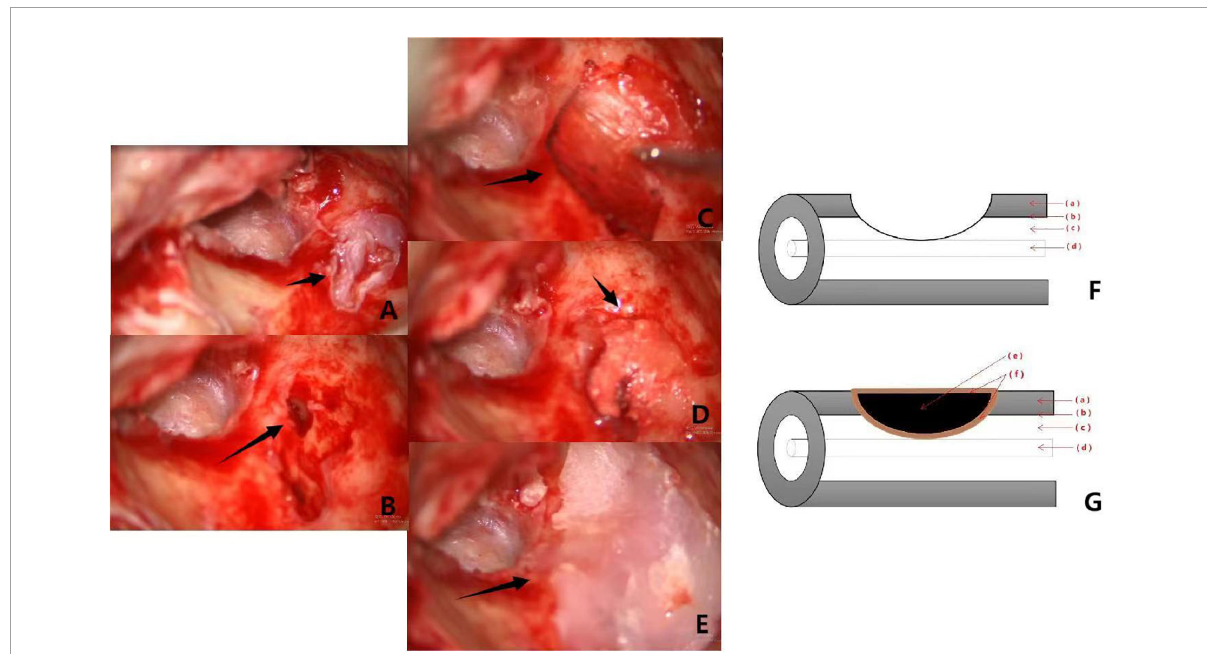
FIGURE3 Pictures (A–E) are intraoperative of a patient with type III labyrinthine fistula. (A) : Type III labyrinth fistula with the superficial cholesteatoma epithelium located deep in the external semicircular canal (the black arrow). (B) : Cholesteatoma epithelium on the surface of the fistula (the black arrow). After the cholesteatoma epithelium is cleaned “under water,” the membrane labyrinth is destroyed. (C) : The fascia is placed on the surface of the fistula (the black arrow). (D) : Clean bone powder is placed on the fascia and the external semicircular canal is filled with a “pie” shape (the black arrow). (E) : The surface of the semicircular canal is covered with bone wax (the black arrow). (F,G) Show the preoperative and postoperative pattern diagram of a patient with type III labyrinteric fistula. The red arrows (a–f) respectively, represent the bony labyrinth, endosteum, perilymphatic space, membranous labyrinth, bone meal, fascia.